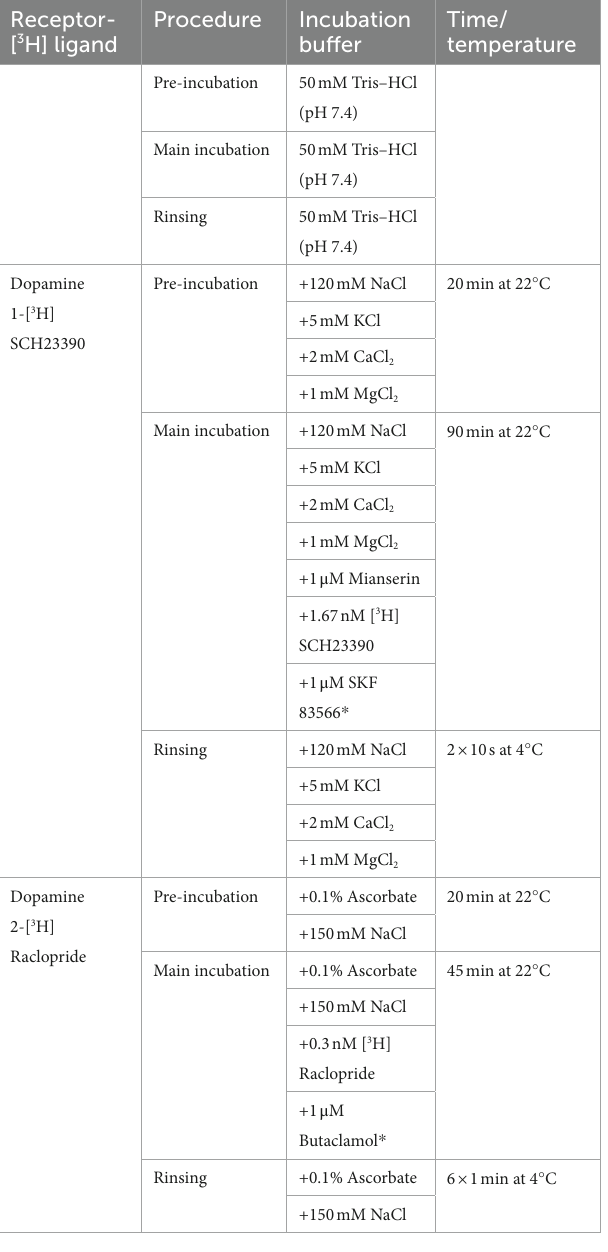
TABLE 1 Receptor binding protocols for the dopaminergic [ 3 H] ligands with competitors (noted with * ) and incubation